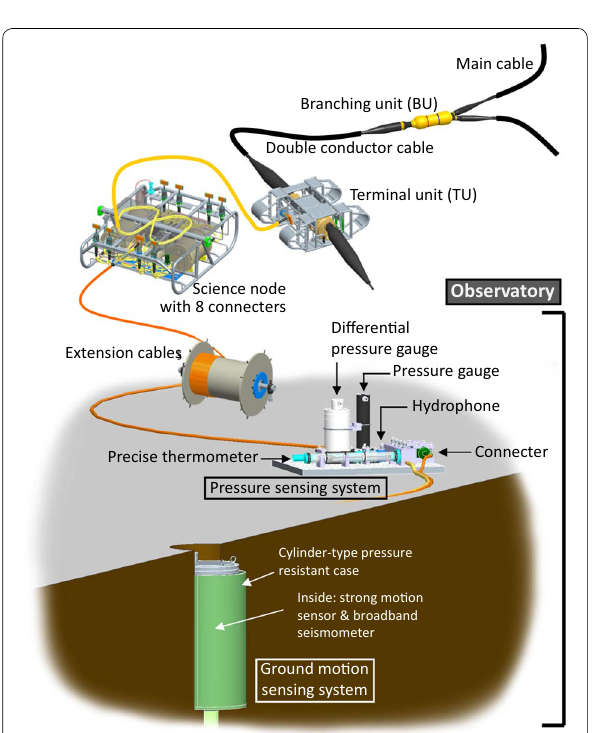
Fig. 8 Schematic view of the DONET